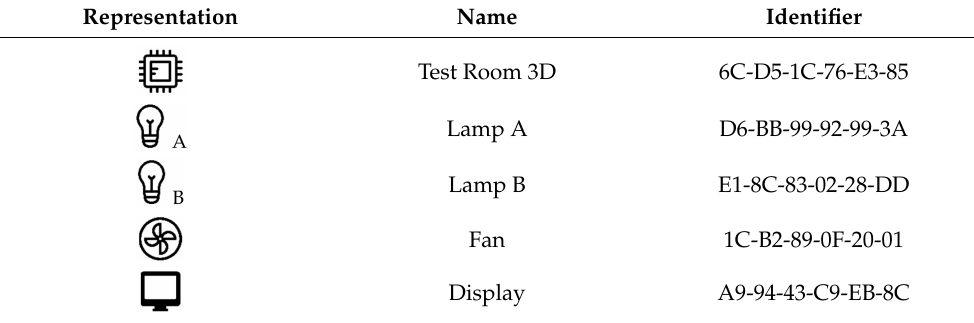
Figure 9. Two-dimensional actuators and sensors in action: ( a , b ) with regard to Lamp A and B, respectively, turned on and turned off; ( c , d ) represent the pair of fans (Fan A and Fan B) simulating different rotation intensities, from stopped to highest level; ( e ) depicts the temperature sensor with the lower and the higher reading; and, finally, ( f ) shows the motion sensor, performing in idle and active state. Table 7. Three-dimensional environment virtual devices, composed of two lamps, a fan, and a